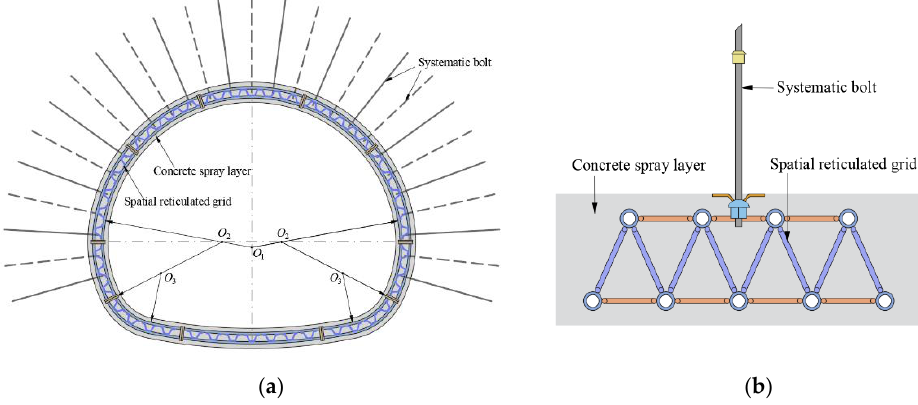
Figure 1. The SRGB support structure. ( a ) The components of the support system and ( b ) sectional structure feature.